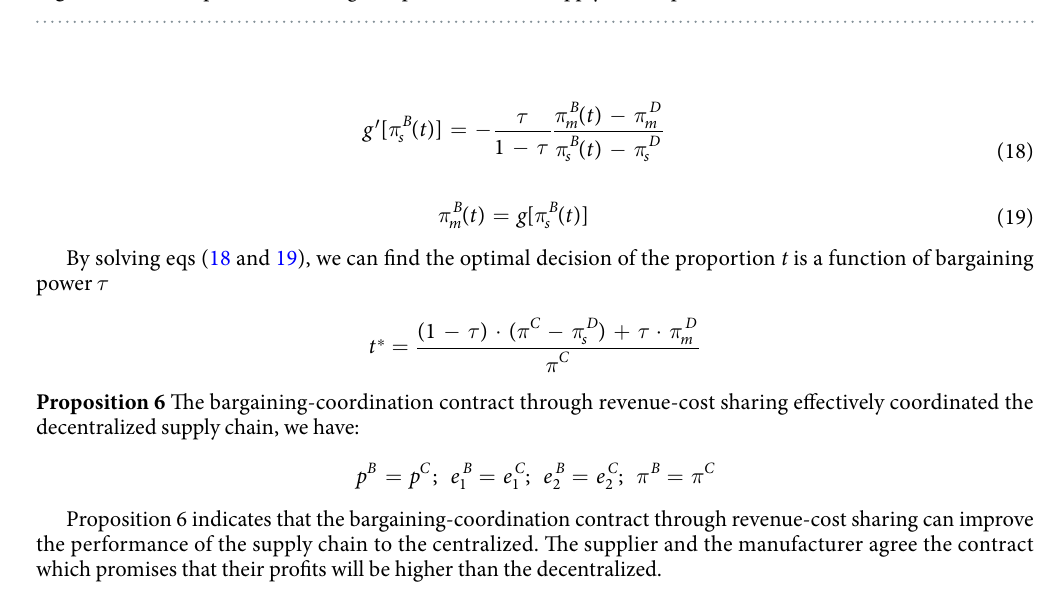
Figure 12. The impact of technological spillovers on the supply chain’s profit in the decentralized scenario.